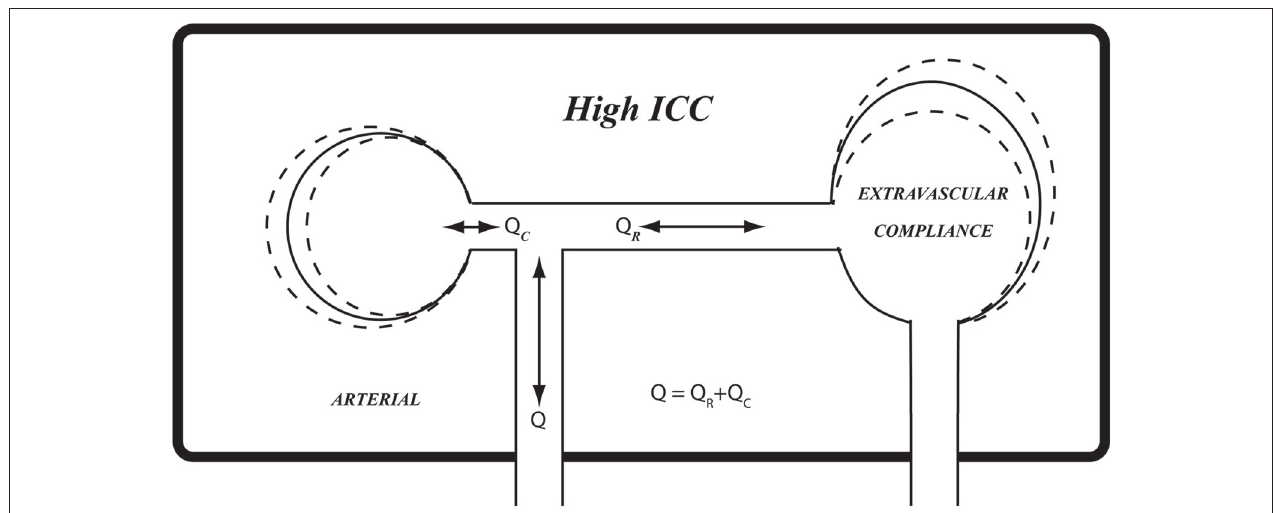
FIGURE 8 | A schematic representation of extravascular compliance within the rigid skull, as discussed in the text. While compliance of cerebral vasculature is constrained within the rigid skull, compliance of other elements within the skull, such as soft brain tissue, venous and spinal fluid volumes, provide extravascular sources of compliance. The combination of prevailing intravascular and extravascular compliance is what we referred to as intracranial compliance ( ICC ) as distinct from intracranial pressure ( ICP ). The relationship between pulsatile pressure and flow within the skull is governed by ICC rather than by compliance of the cerebral vascular bed. High ICC , as shown here schematically, may be likened by analogy to fully inflated balloon.